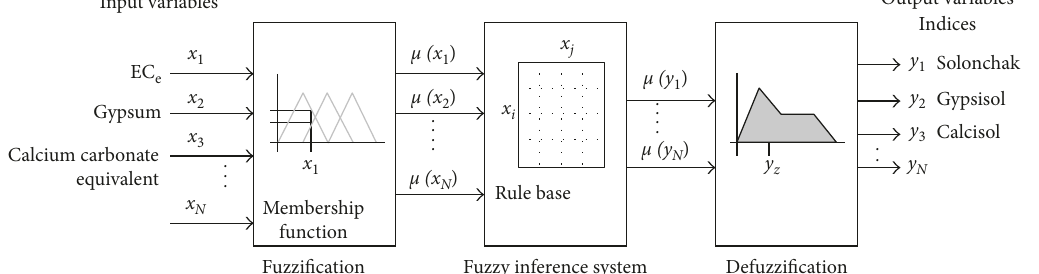
Figure 2: Reasoning of the database schema by a fuzzy inference system.